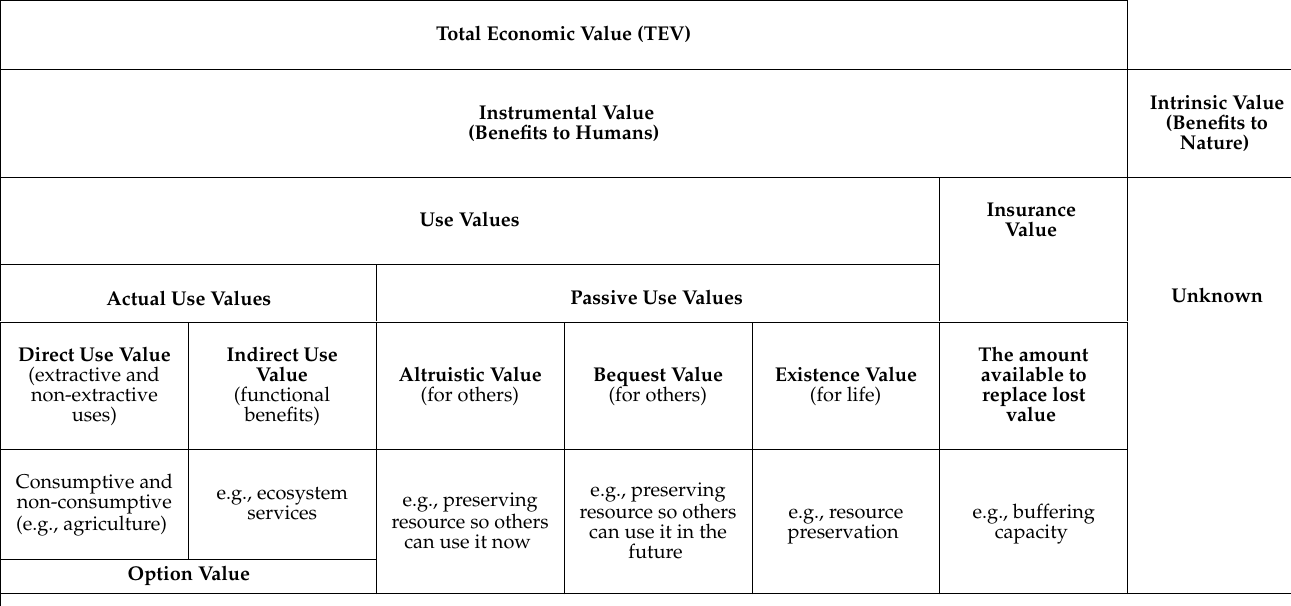
Total Economic Value (TEV) Instrumental Value (Benefits to Humans)